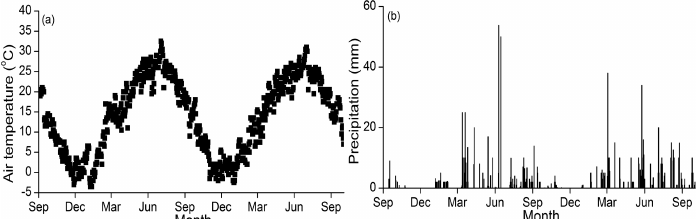
Fig 1. The average of daily air temperature (a) and daily precipitation (b) during the experimental period (from Oct 2013 to Oct